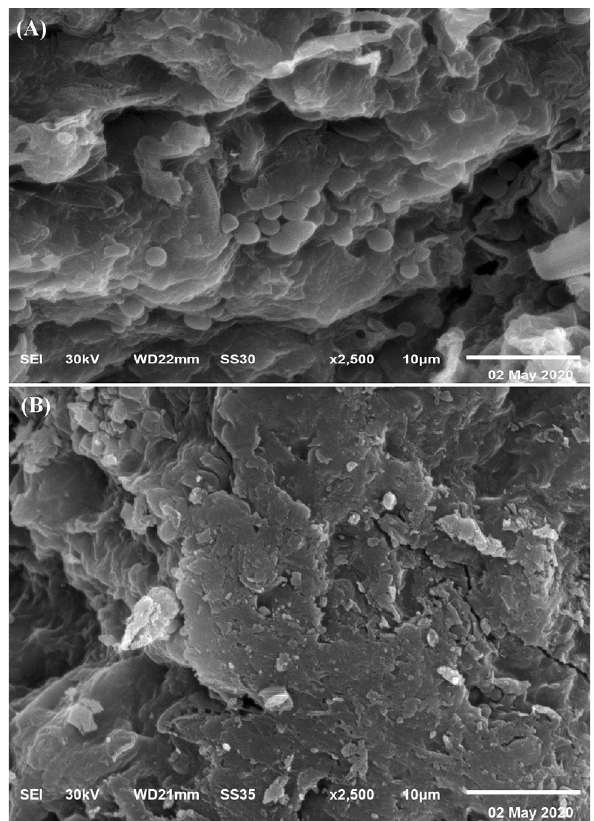
Figure 5. SEM micrograph of F. vesiculosus (A) before and (B) after biosorption of MO and copper ions from aqueous